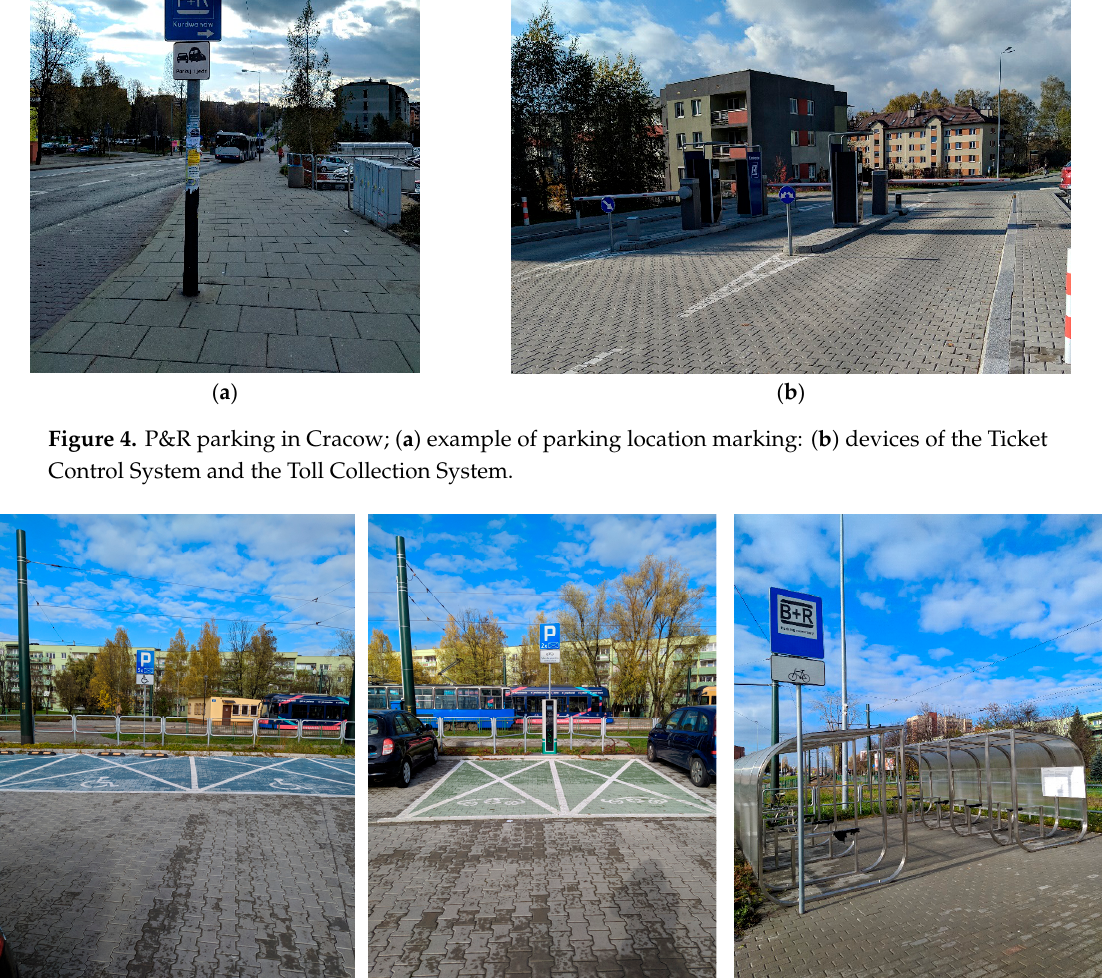
spaces for disabled people; ( b ) parking spaces for electric car drivers equipped with devices for charging